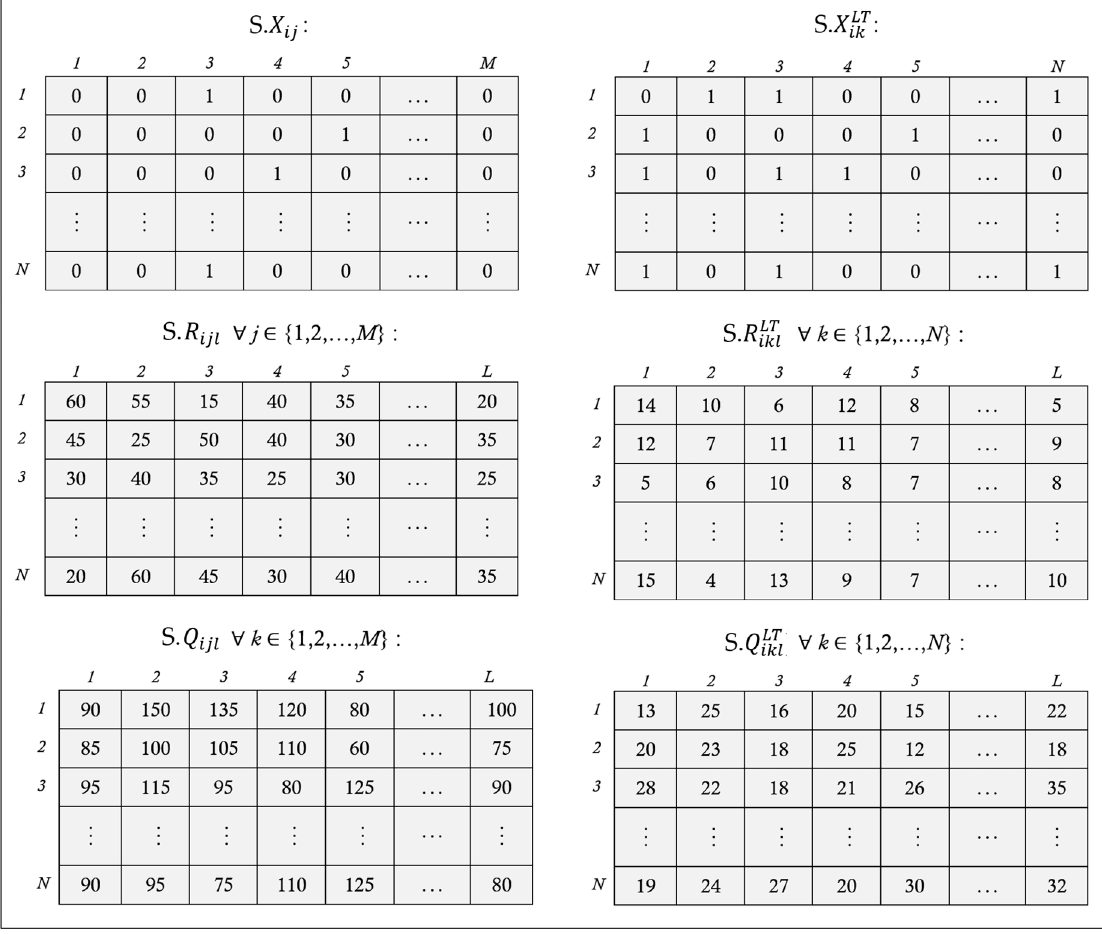
Figure 3. Representation of a grey wolf (i.e., a feasible solution).